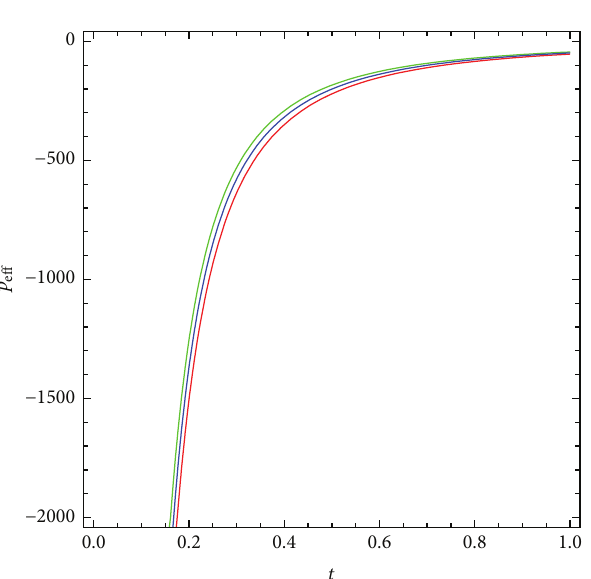
̇Π Figure 3: Plot of based on (20). Red, green, and blue lines correspond to {𝛼, 𝛽} combination of {0.9735, 3701} with 𝜂 = 3.5 × 10 −4 , 3.0 × 10 −4 , and 2.5 × 10 −4 , respectively.